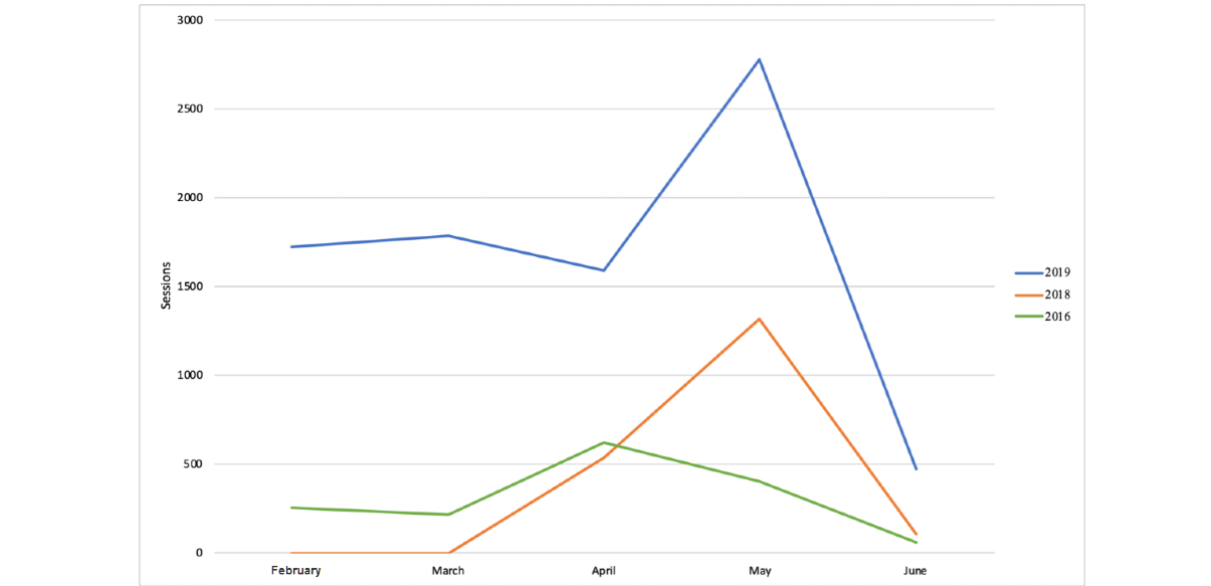
Figure 8. Exam period usage patterns from 2016 to 2019. The exam period is usually at the end of the spring semester, either at the beginning or end of May each year.